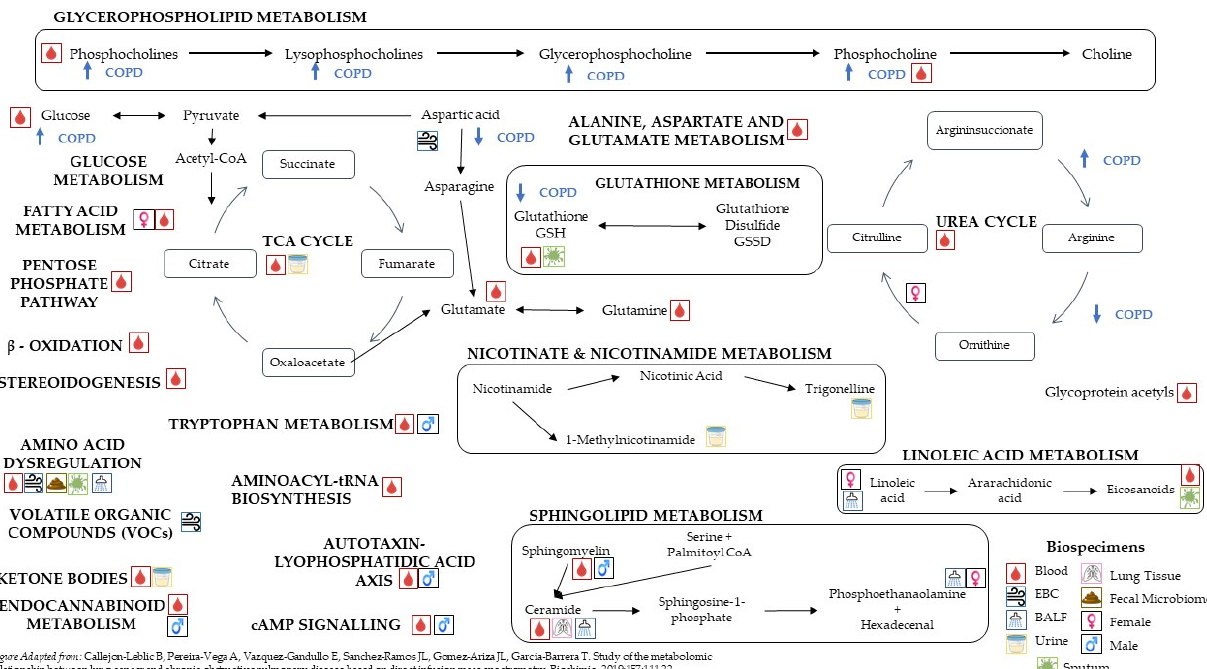
Figure 1. Pathways affected by COPD